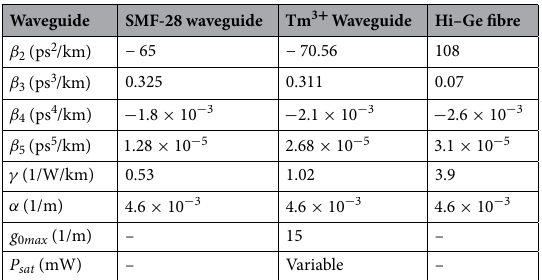
Table 1. Active and passive fibre characteristics.